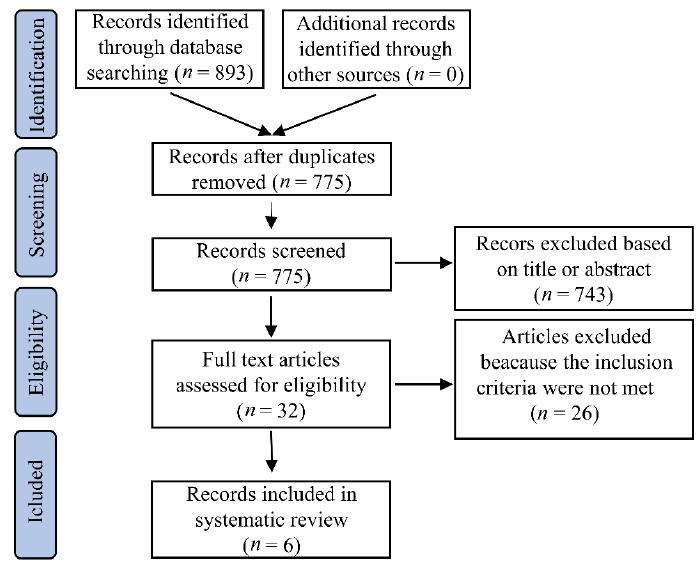
Figure 1. Flow diagram of selected studies for inclusion in the systematic review. The characteristics of studies and population included and the outcomes measured were summarized in Table 1. Table 1. General characteristics of studies included in present systematic review.